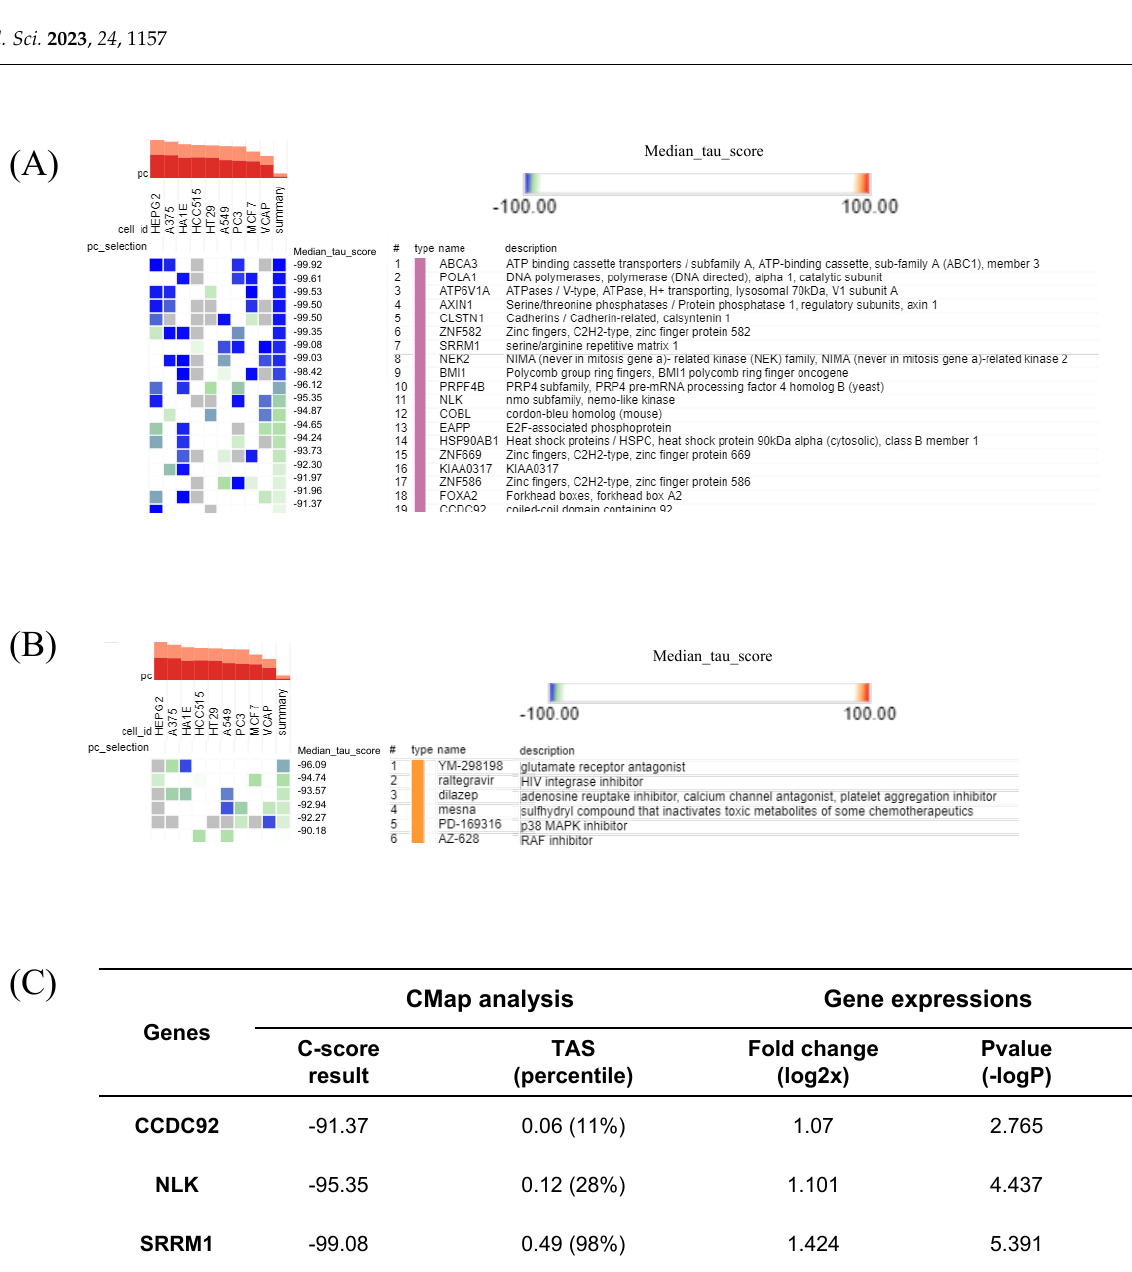
Figure 8. Connectivity Map (CMap) analysis results showing ( A ) significant perturbation genes with the least CMap connectivity score; ( B ) significant perturbation compounds; and ( C ) three significant genes presented with their CMap score, fold-change, p -value, and TAS (transcriptional activity